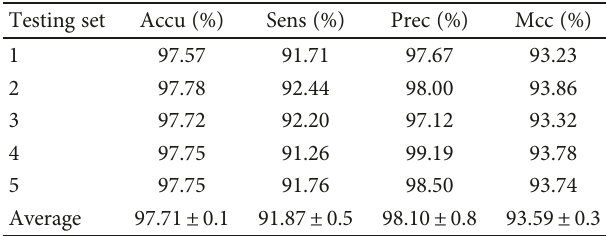
Table 2: 5-Fold cross-validation results using the proposed method on the unbalanced-human dataset.